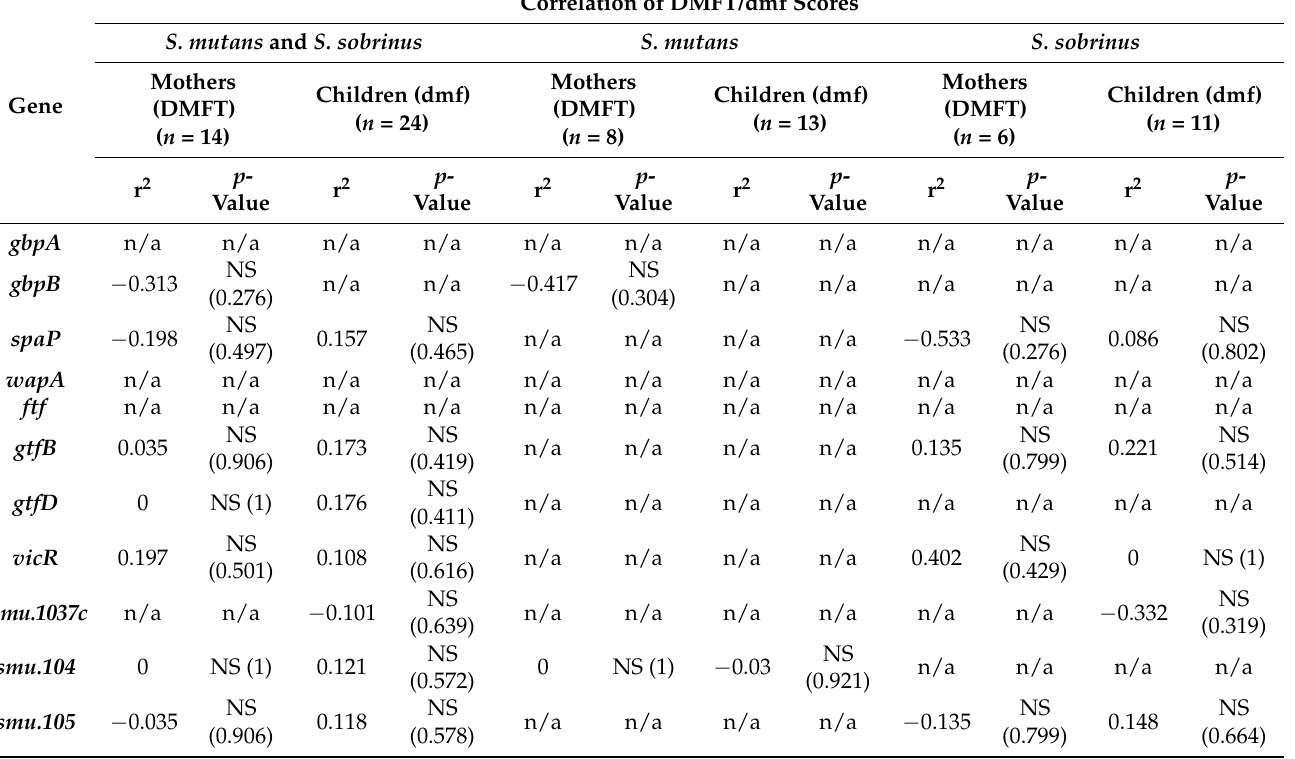
Table 4. Relationship between DMFT index and virulence genes between mutans streptococci in mothers and dmf index and virulence genes between mutans streptococci in children. Each